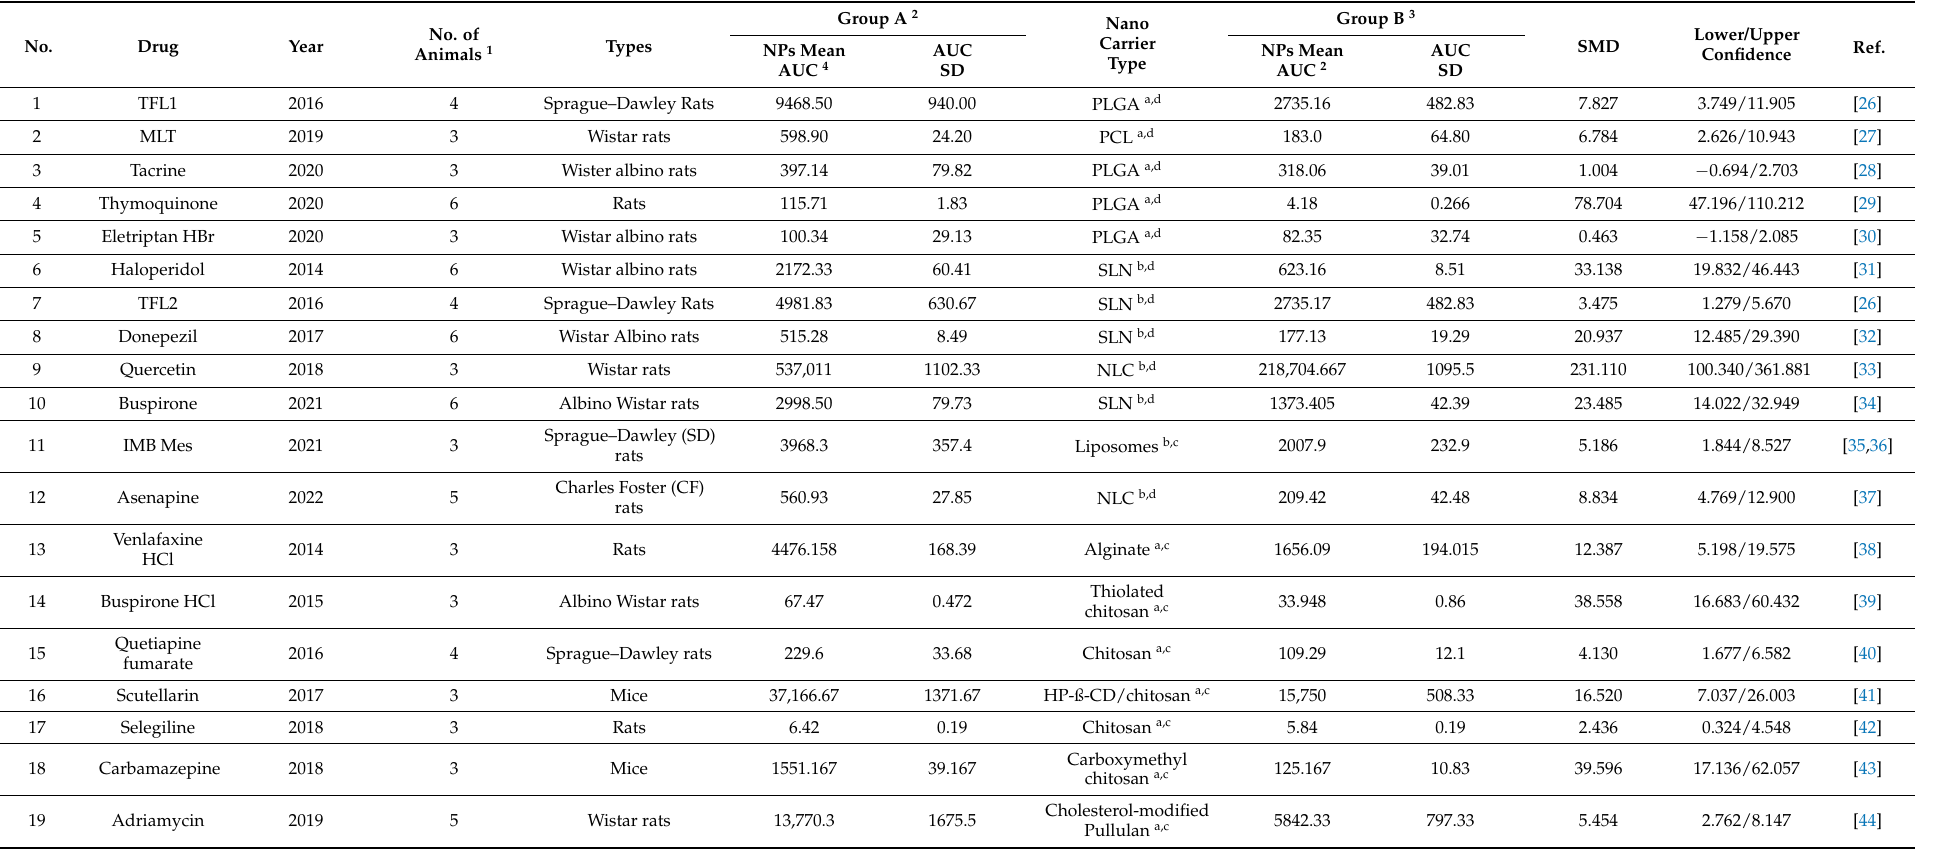
Table 1. Meta-Analysis of area under the curve (AUC) in studies of intranasal loaded drugs in lipid and polymeric nanoparticulate systems as compared with their controls (conventional